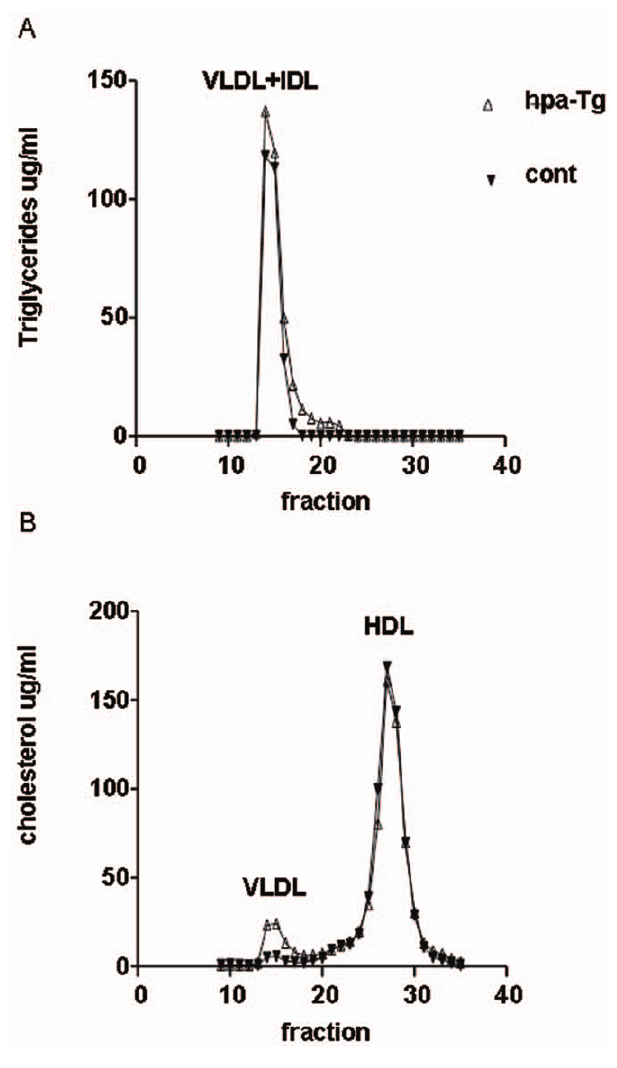
Figure 1. Distribution of triglyceride (A) and cholesterol (B) in the plasma of hpa-Tg (open triangles) and control C67BL/6 mice (closed triangles). Pooled plasma samples of 4 fasting mice from each group were applied to FPLC analysis. As indicated in the figure, triglyceride levels are increased in the non-HDL fractions (A), and cholesterol level is slightly increased in the VLDL + IDL fractions (B) of the hpa-Tg mice compared to controls. AUC ( m g/ml x fraction) of C57BL/6 triglyceride was 281 compared to 393 of hpa-Tg whereas the AUC of C57BL/6 total cholesterol was 662 compared to 705 of hpa-Tg mice. The AUC of VLDL-cholesterol peak was 20 compared to 74 of hpa-Tg mice. PLoS ONE |